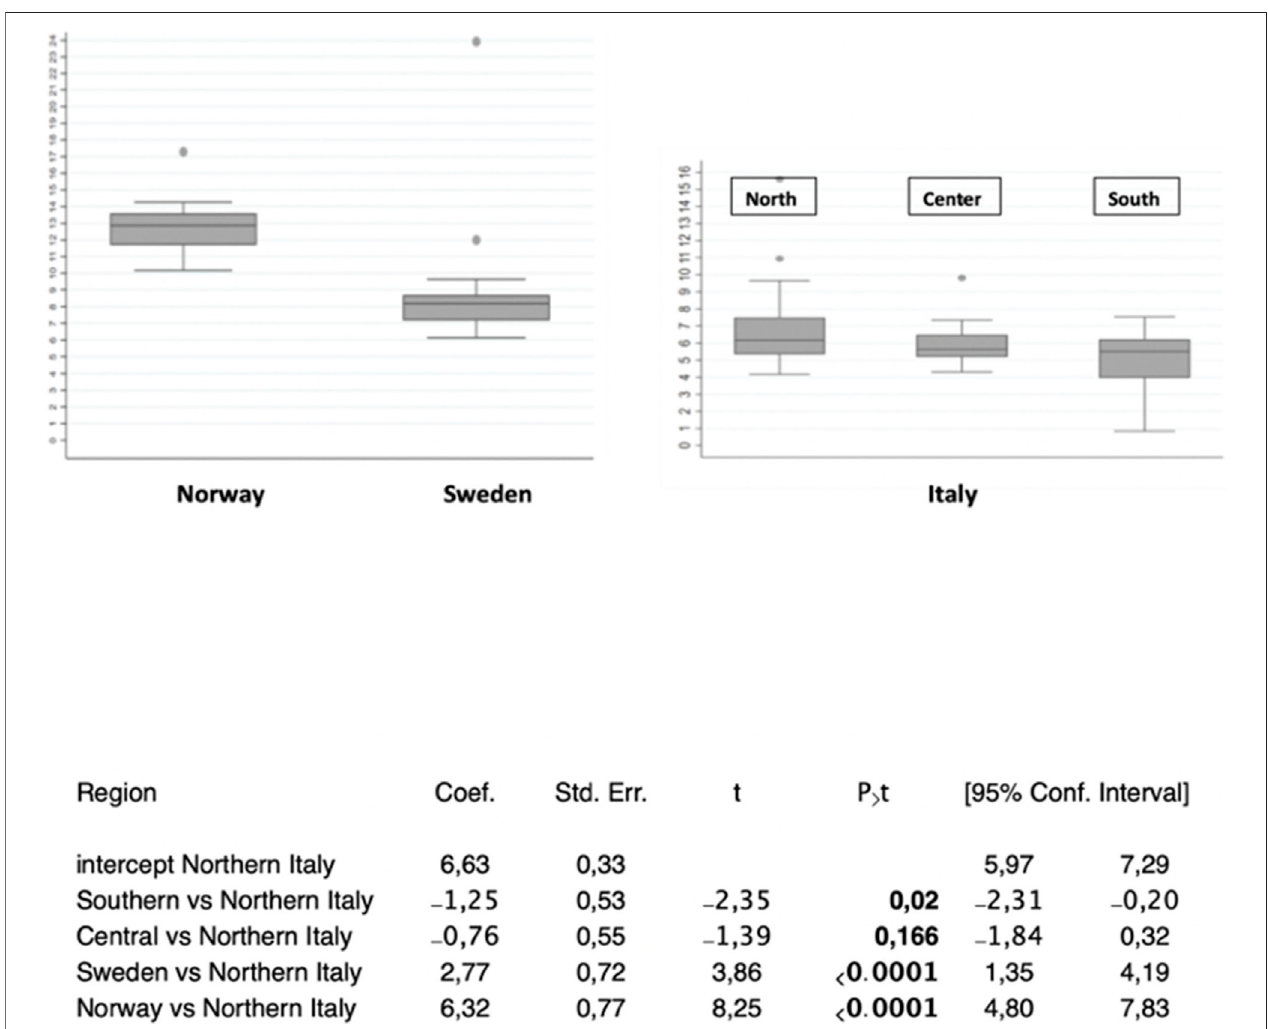
FIGURE 3 | COVID-19 diffusion across geographic areas. (top) Distribution boxplots of doubling times of COVID-19 cases in the areas/countries analyzed. (bottom) Doubling times of COVID-19 cases versus the Northern Italy benchmark, which corresponds to the central intercept. Coef.: coef fi cient; Std. Err.: standard error; 95% con fi dence intervals are shown. P > t: P value of comparison versus the